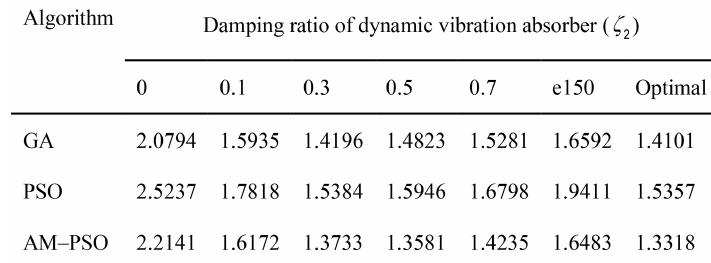
Mech. Sci., 13, 505–517,